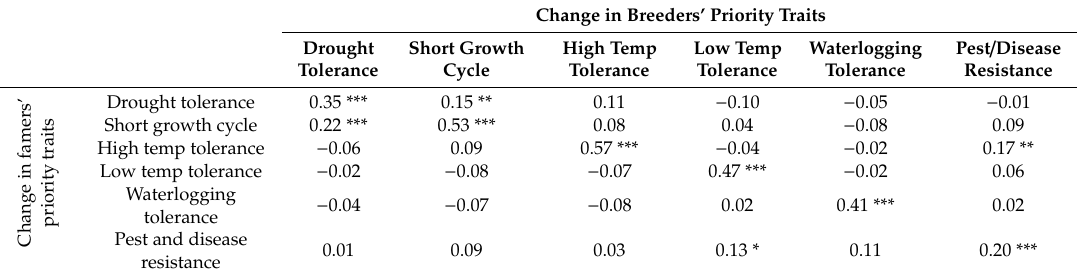
Table 3. Association between breeders’ priorities and breeders’ perceived farmers’ preferences for traits. Drought